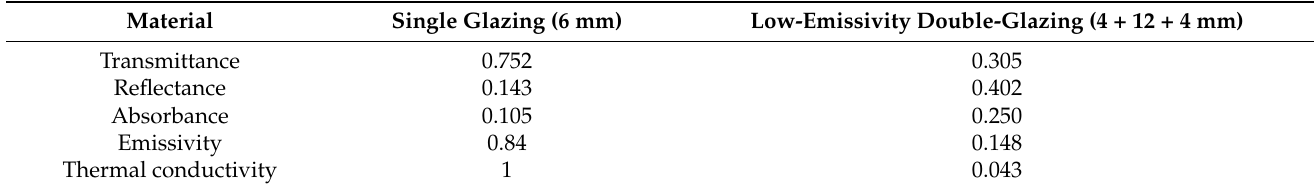
Table 3. Assumed properties of simulated glazing unit.